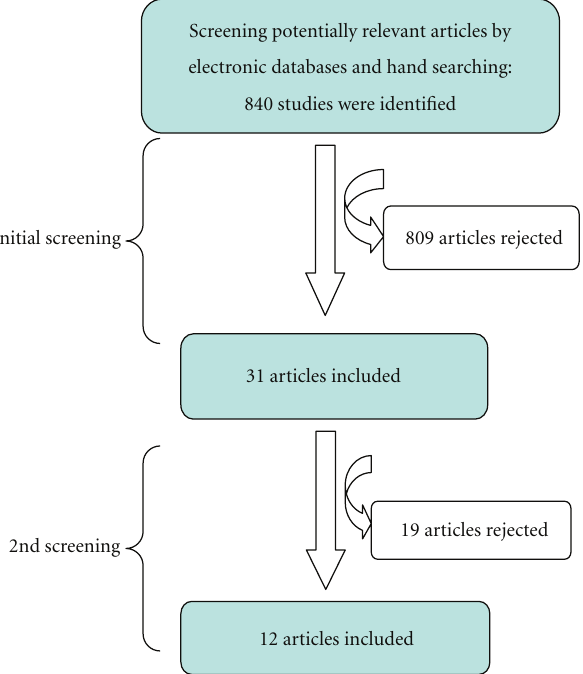
Figure 1: Flow diagram of the study selection